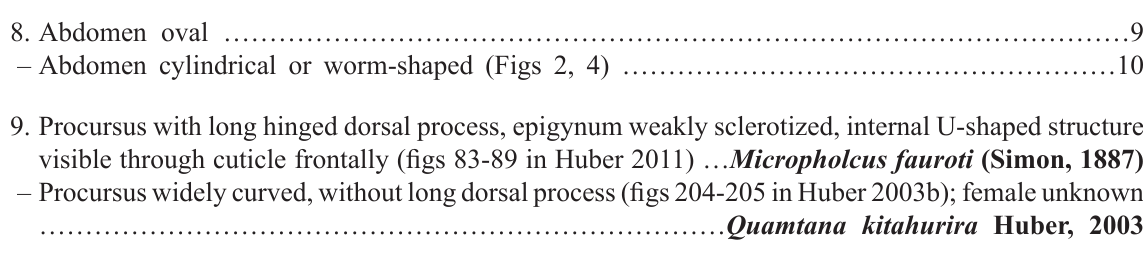
Huber b.A. & WArui C.M., east African pholcid